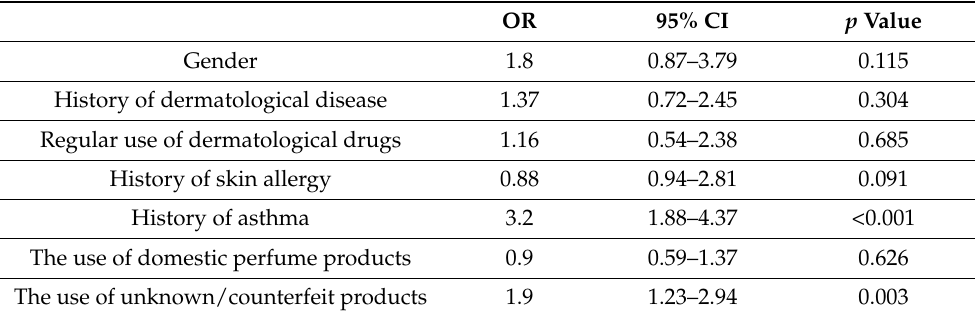
Table 4. Multivariate regression analysis of perfume sensitivity risk factors.